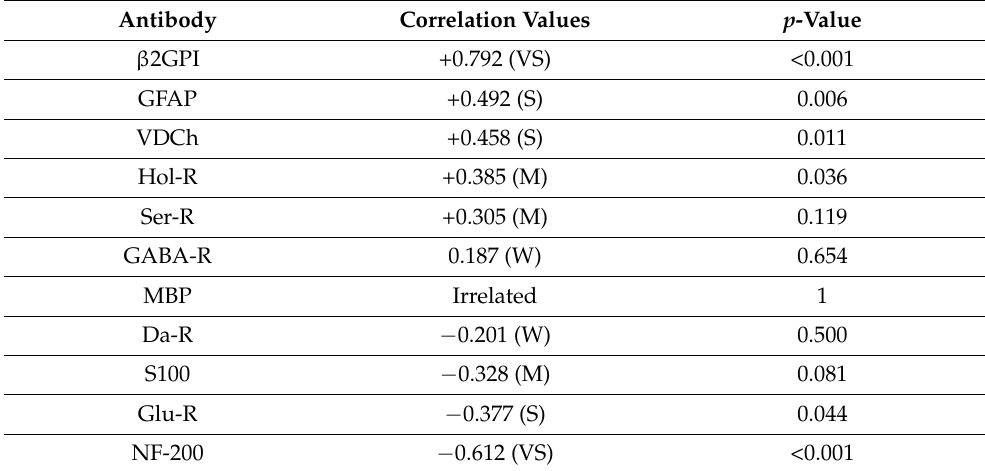
Table 2. The risk of developing or not developing chronic fatigue syndrome with a certain autoantibody evaluation. VS, very strong correlation; S, strong correlation; M, moderate strength correlation; W, weak correlation; “+” , positive correlation; and “−” , negative correlation.